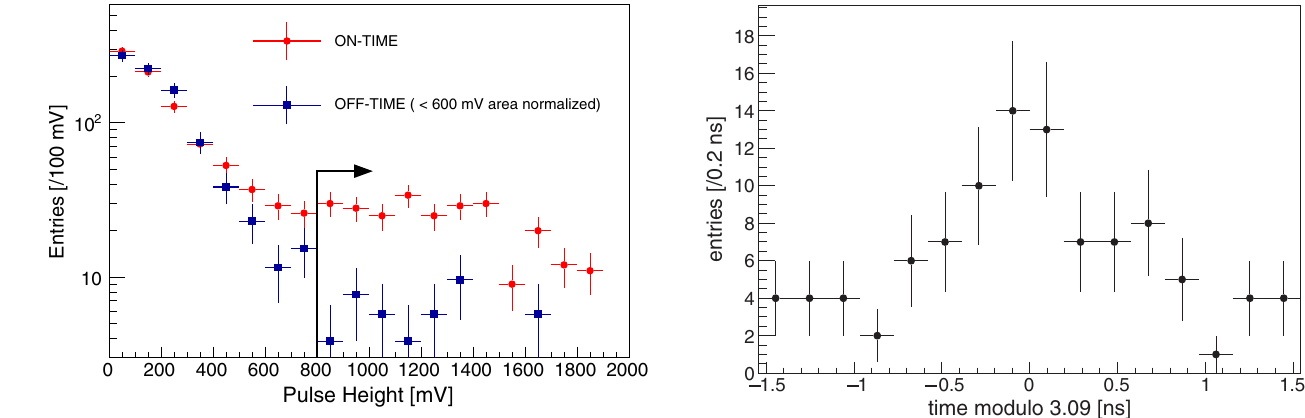
FIG. 11. Time difference distribution modulo 3.09 ns obtained using the TDC data.